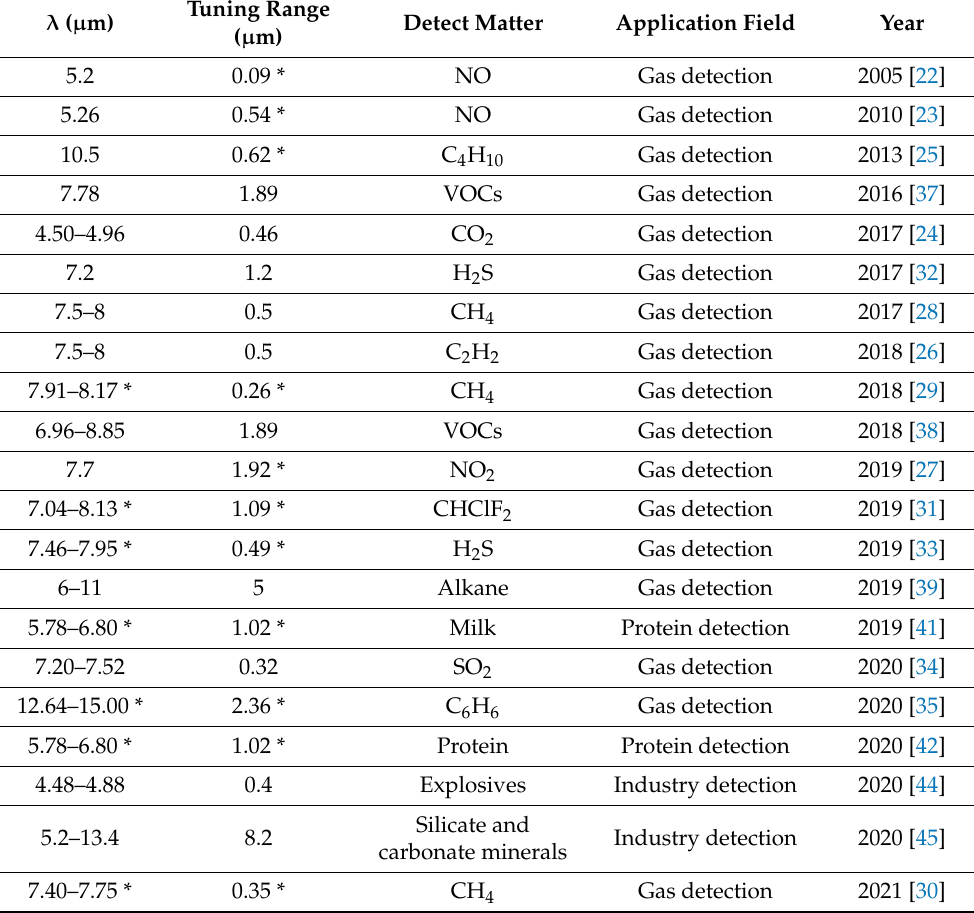
Table 2. The applications of ECQCLs and the detection